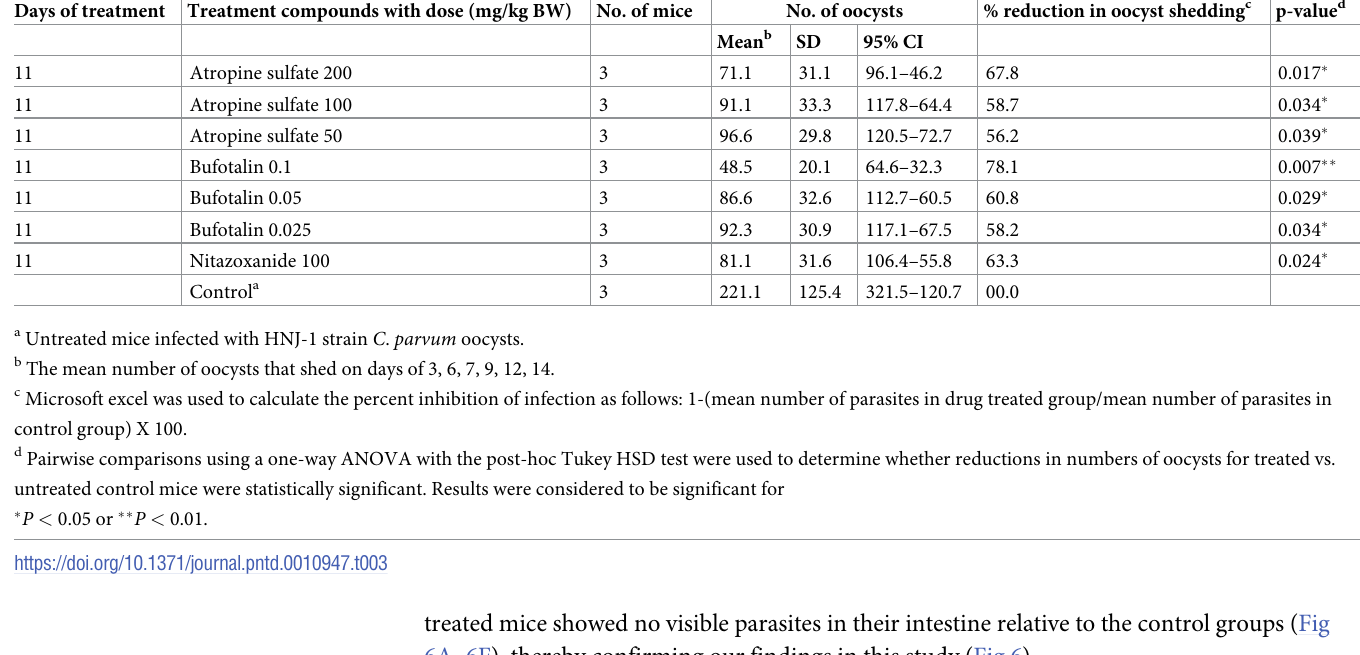
Table 3. Efficacies of TCM compounds with nitazoxanide for reducing oocyst shedding from the distal colon of C . parvum -infected neonatal SCID mice. Days of treatment Treatment compounds with dose (mg/kg BW) No. of